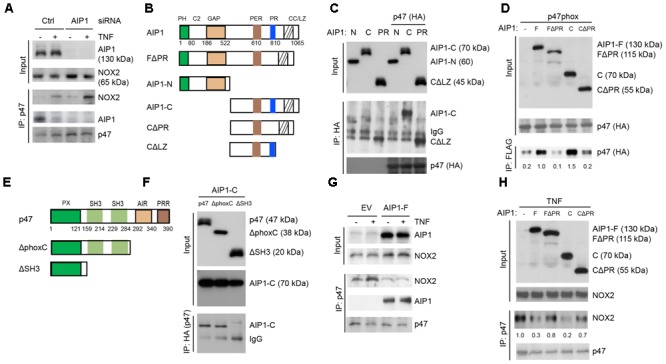
AIP1 blocks NOX2 activity in EC by disrupting the formation of an active NOX2 complex. (A) Association of AIP1 with p47phox. HAEC were transfected with control siRNA or AIP1 siRNA. Twenty four hour post-transfection, cells were either left untreated or treated with TNFα (10 ng/ml) for 15 min. AIP1-p47phox and NOX2-p47phox complexes were determined by a co-immunoprecipitation assay followed by Western blot as indicated. (B) Schematic diagram for AIP1 structural domains and expression constructs. PH, PH domain; C2, PKC conserved domain; GAP, GTPase-activating protein domain; PER, period-like domain; PRR, proline-rich region; CC/LZ, coiled coil/leucine-zipper domain. Various AIP1 N-terminal truncates (FΔPH and AIP1-N) and C-terminal truncates (AIP1-C; C-PR, C-ΔPR) constructed with a Flag-tagged at the N-terminus are shown. (C,D) AIP1 via its PRR binds to p47phox. Various AIP1 truncates were co-transfected with HA-tagged p47phox into HAEC cells as indicated. Associations of AIP1 truncates with p47phox were determined by co-immunoprecipitation with anti-HA (for p47phox) followed by Western blot with anti-Flag (for AIP1 truncates). Immunoprecipitated AIP1 truncates are indicated. (E) Schematic diagram for the p47phox structural domains and expression constructs. PX, phosphoinositide-binding structural domain; SH3, Src homology 3 domain that binding to proline-rich region (PRR); AIR, autoinhibitory region; PPR, proline-rich region (PRR). ΔphoxC: a mutant with the deletion of both AIR and PPR; ΔSH3: a mutant with the deletion of the two SH3 domains. (F) p47phox via the SH domains bind to AIP1. HA-tagged p47phox truncates were co-transfected with FLAG-tagged AIP1-C into HAEC as indicated. Associations of p47phox truncates with AIP1-C were determined by co-immunoprecipitation with anti-HA (p47phox) followed by Western blot with anti-Flag (AIP1-C). AIP1-C and IgG in the immunoprecipitation are indicated. (G,H) AIP1 prevents/disrupts NOX2-p47phox complex formation. HAEC were infected with lentivirus with empty vector (EV), AIP1-F (E) and with a truncate (F), and cells were left untreated or treated with TNFα (10 ng/ml for 15 min). Cell lysates were subjected to co-immunoprecipitation assays with anti-p47phox followed by Western blot with anti-NOX2. All experiments were repeated three times.